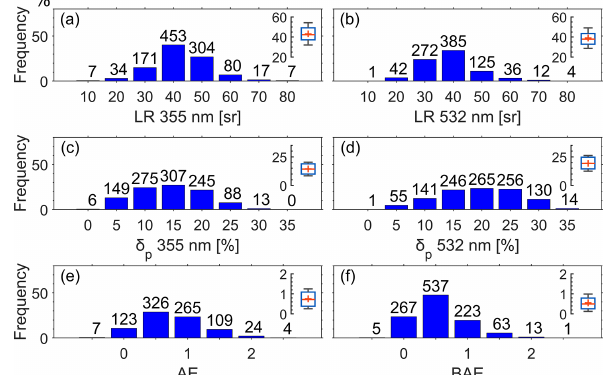
Figure 6. Frequency distribution of (a) lidar ratio at 355nm with bin width of 10sr. (b) Lidar ratio at 532nm with bin width of 10sr. (c) Linear particle depolarization ratio at 355nm with bin width of 5%. (d) Linear particle depolarization ratio at 532nm with bin width of 5%. (e) Extinction-related Ångström exponent (AE) at 355/532 with bin width of 0.5. (f) Backscatter-related Ångström exponent (BAE) at 355/532 with bin width of 0.5. Box and whisker plots are also presented, where the cross is the mean value, the horizontal line is the median, boxes are the 25th and 75th percentiles, respectively, and whiskers represent the 1 standard deviation. The numbers above the bars indicate the number of cases fallen in the